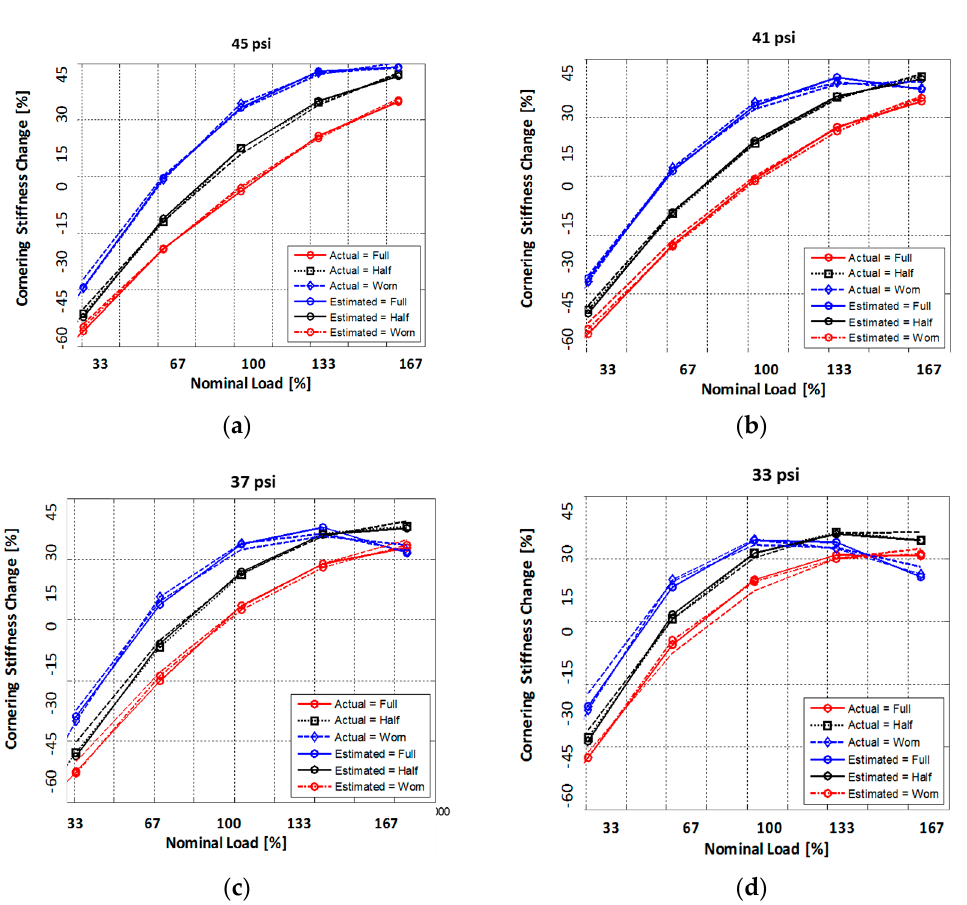
Figure 18. Tire cornering stiffness: actual (measurement) versus estimated (using adapted model). Model fitting performance at: ( a ) 45 psi, ( b ) 41 psi, ( c ) 37 psi and ( d ) 33 psi.